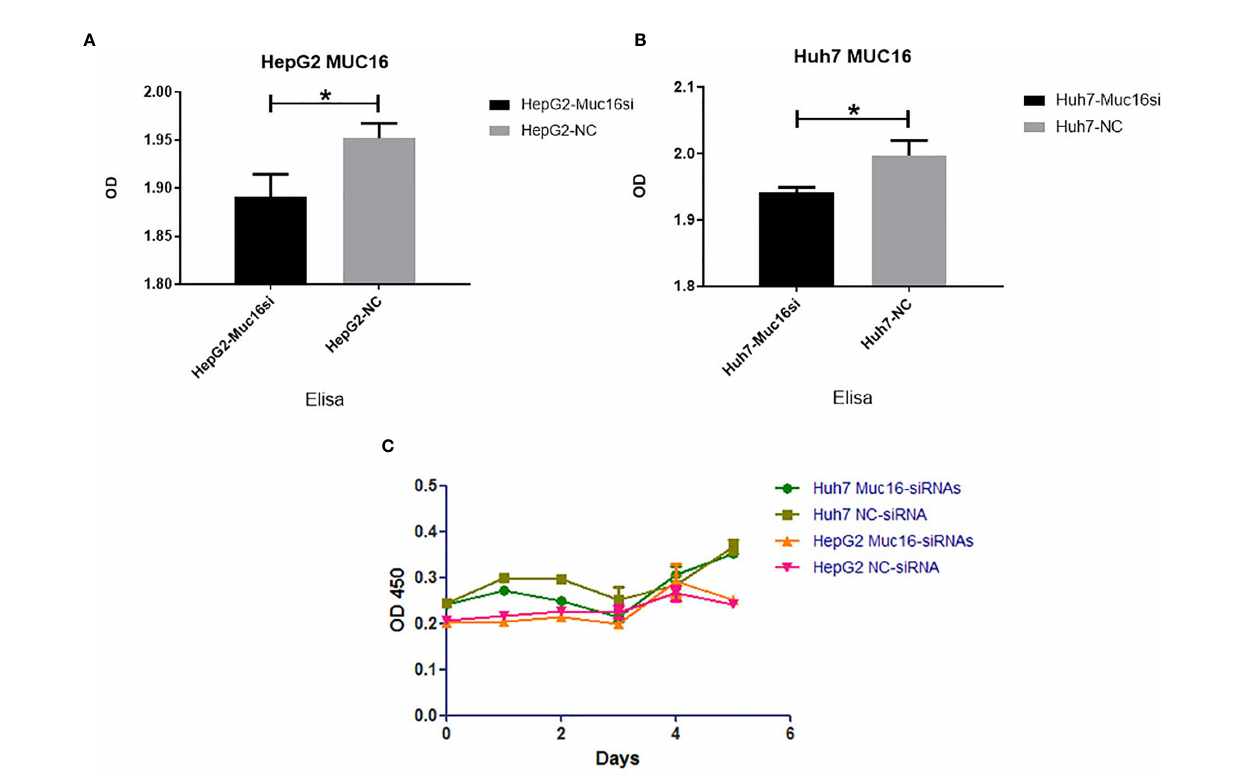
FIGURE 4 | In fl uence of MUC16 knockdown on cellular proliferation. ELISA results of MUC16 knockdown in (A) HepG2 cells and (B) Huh7 cells. (C) The effects of MUC16 knockdown on cellular proliferation at prolonged time points, as detected by CCK8 assay. *, represents p < 0.05.